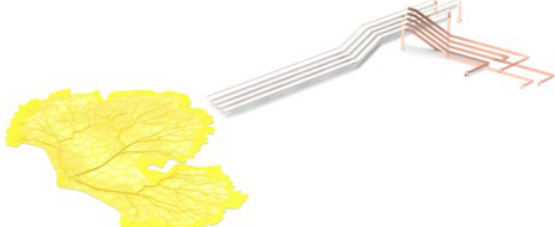
Figure 5 | Bhiobrid system, a graphic representation, Cesar & Lois and DaTA